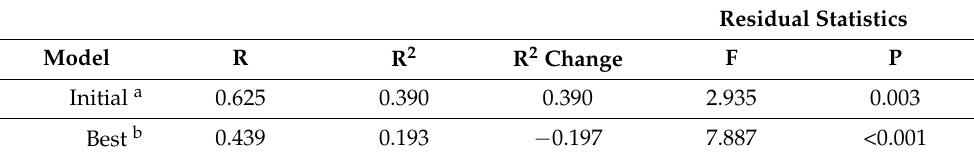
Table 3. Coefficients of determination in the initial and best predictive models for HPD